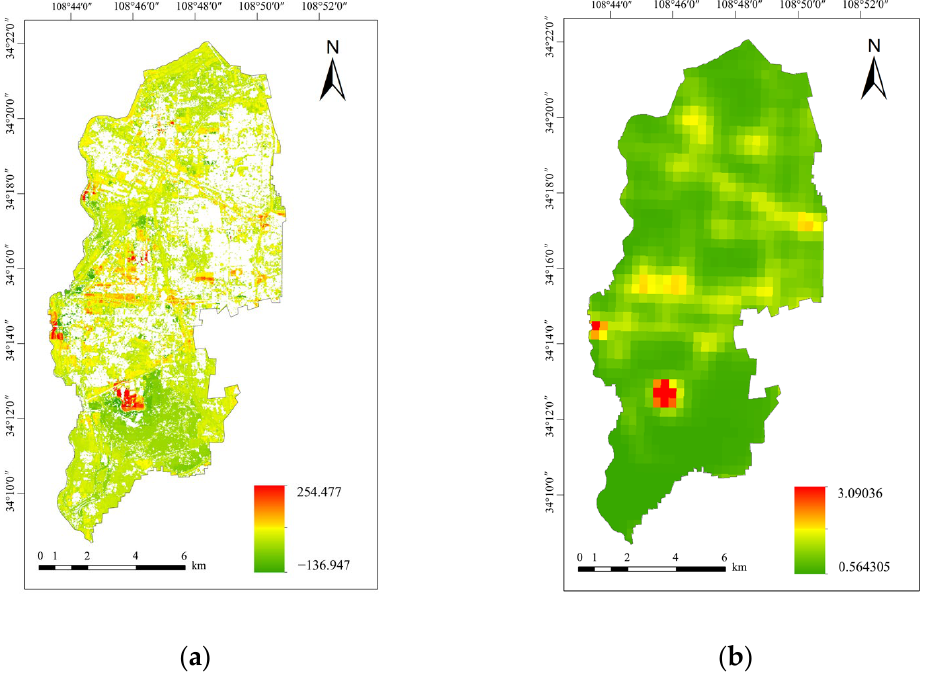
Figure 6. ( a ) Outdoor recreation index; ( b ) scarcity of ecological land.